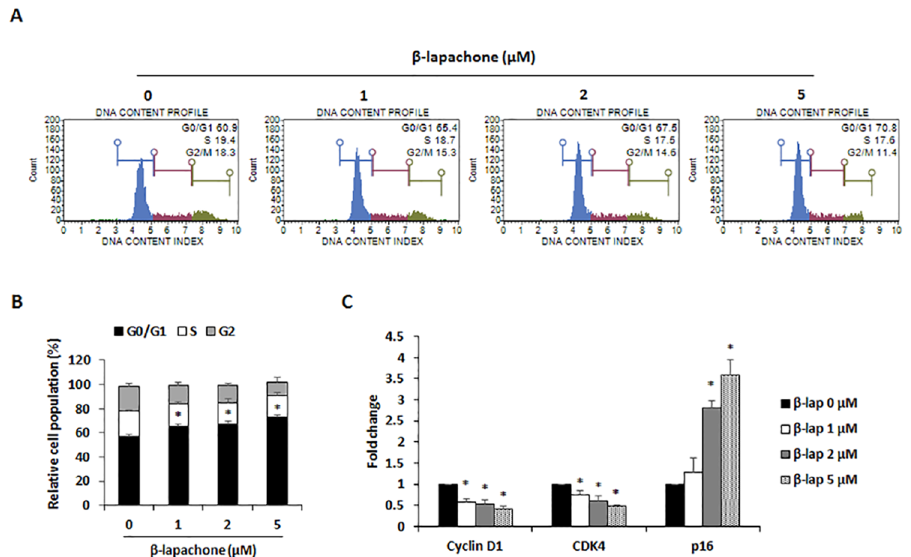
Fig 2. Effect of β -lapachone on cell cycle arrest in B16F10 cells. (A) Cell cycle analysison β -lapachone- treated B16F10cells. The cells were treated with β -lapachone(1, 2, and 5 μ M) for 48 h and fixed with 70% ethanolfor at least 3 h. After centrifugation, cells were stainedwith PI solution and analyzedfor determination of cell cycle phase distribution. Data are representative of three independentexperiments. (B) The percentage of cells in each phaseof the cell cycle. (C) mRNA expressionof cyclin D1 and CDK4. B16F10 cells were treated with indicatedconcentrations of β -lapachone for 24 h. Values are the means ± SD of data from three independentexperiments. * P <